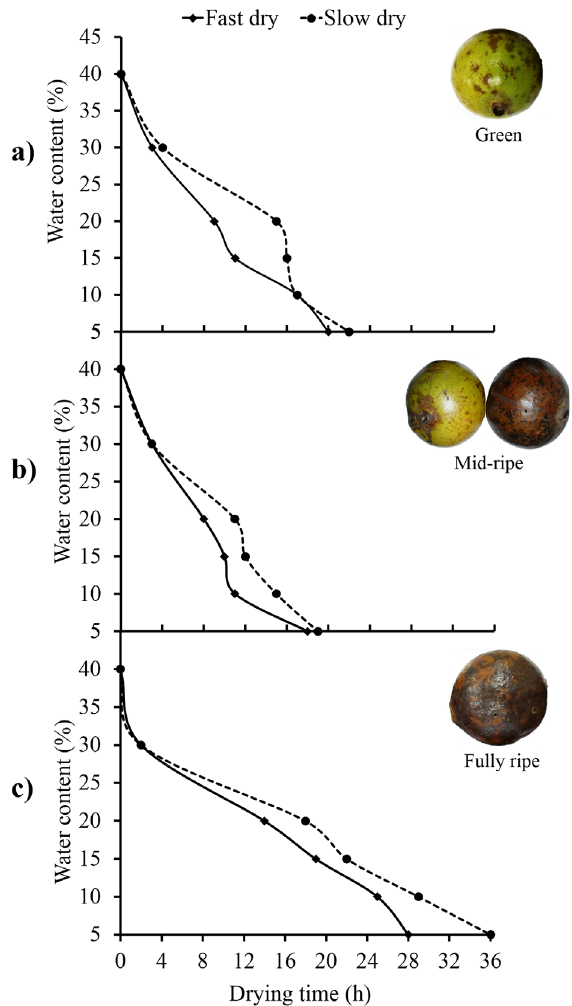
Figure 1 - Drying rate of Alibertia edulis seeds: fast drying (silica gel) and slow drying (room temperature) from fruit in various stages of ripening ( a - green, b - mid-ripe and c - fully